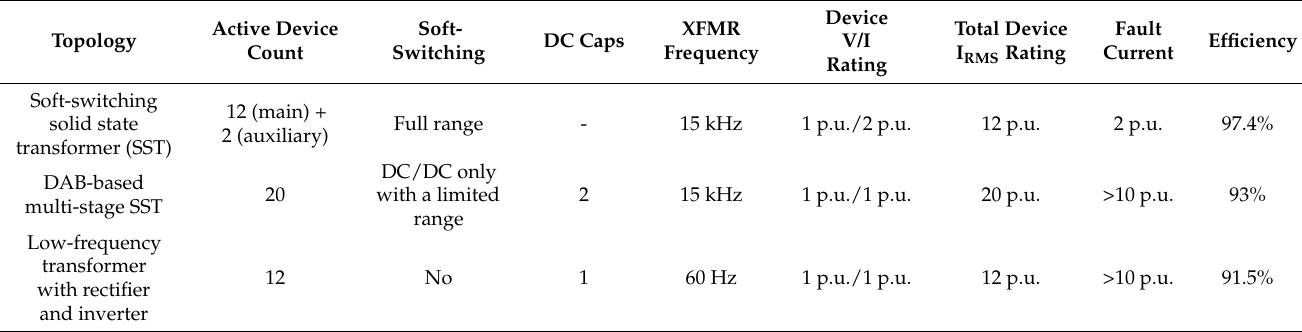
with a switching frequency of 15 kHz